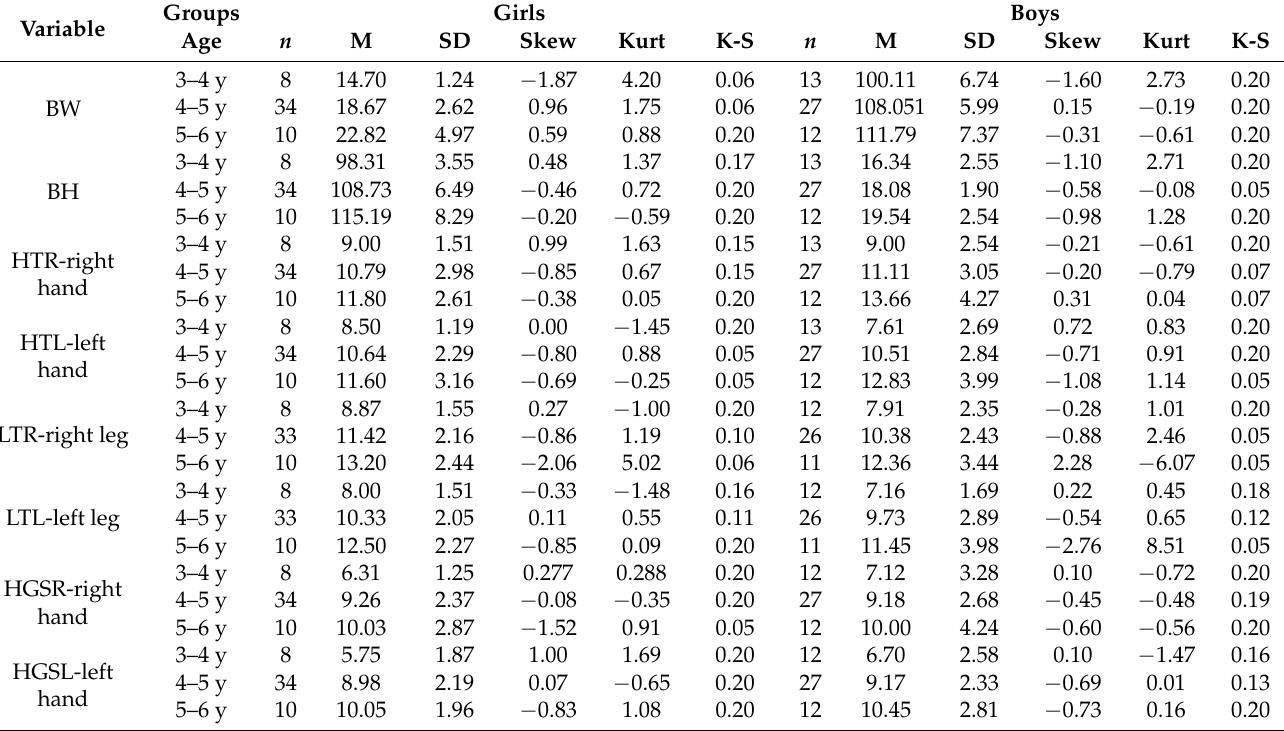
Table 3. Descriptive characteristics of the participants.